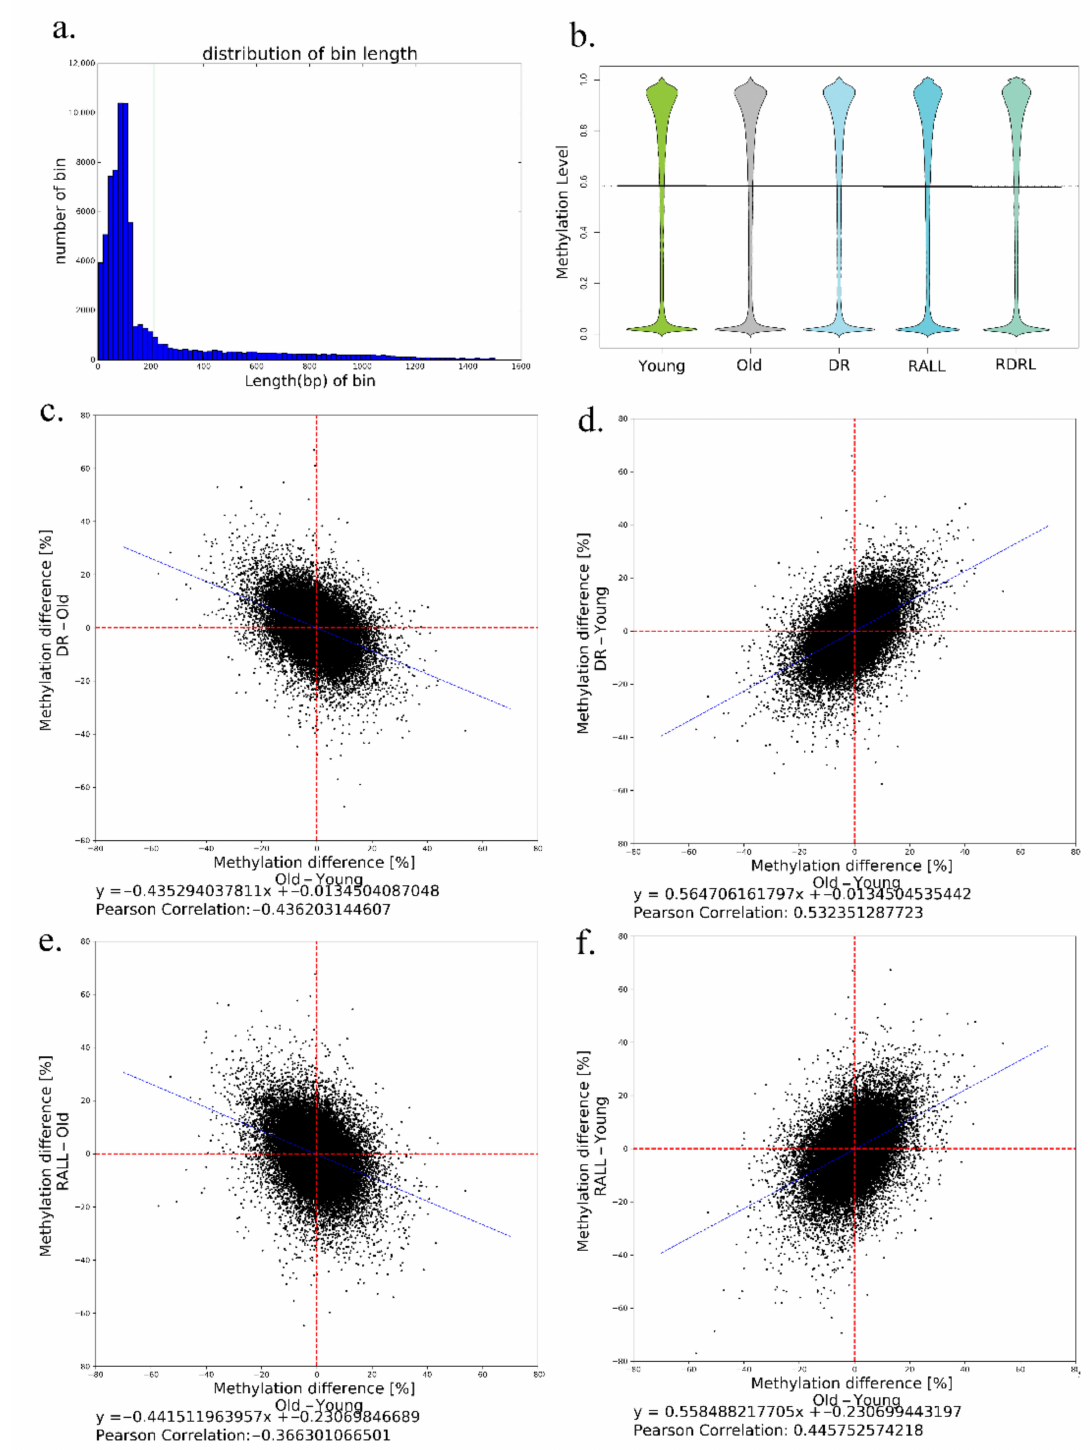
Figure 3. Global DNA methylation variation between different groups. ( a ) Distribution of bin length, in which the bins were created based on sequenced CpG sites, and the distance of adjacent CpG sites in one bin was no more than 1 kb; ( b ) beanplot representation of bin methylation distributions in different groups; ( c , e ) bin-wise methylation difference between age and ( c ) DR or ( e ) RALL; ( d , f ) bin- wise methylation difference between normal aging and aging controlled by DR ( d ) or RALL ( f ). The blue lines in ( c – f ) represent the linear regression lines. Linear regression formulas and the Pearson correlation coefficients are